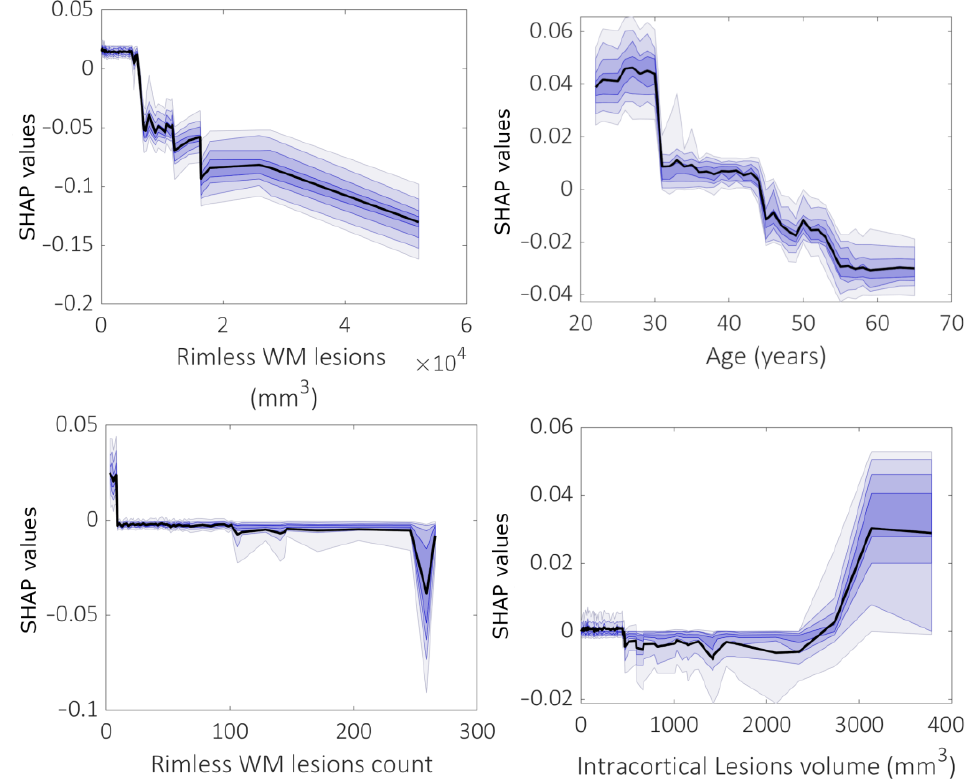
Figure 5. SHAP dependence plots of the rimless WM lesion volume, patient age, rimless WM lesion count and intracortical lesion volume obtained when predicting mean cortical thickness in the whole brain.